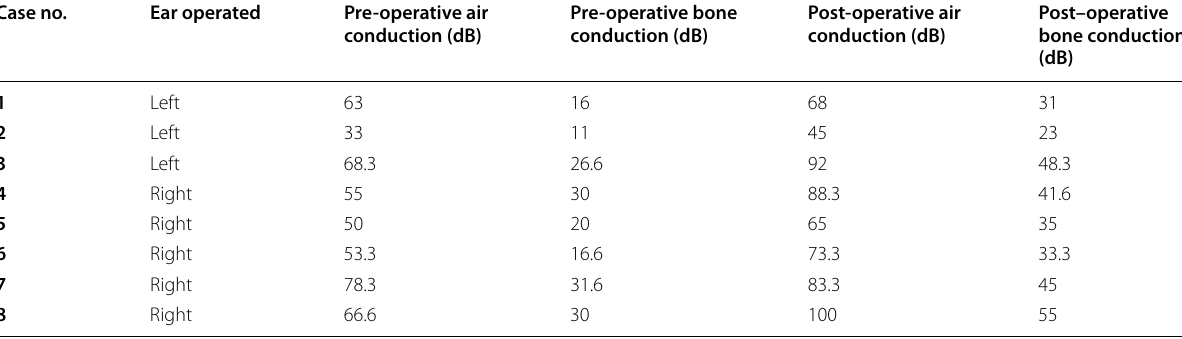
Table 2 Hearing status of patients who had worsening after surgery Case